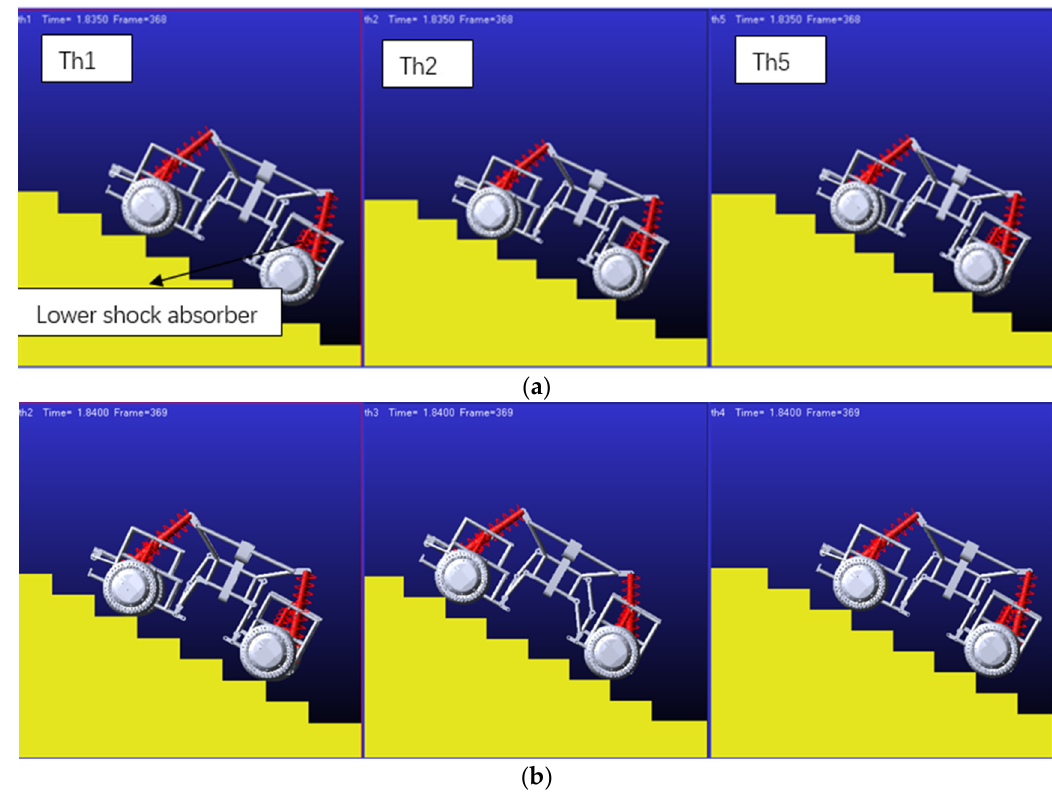
Figure 19. Vehicles with different stiffness shock absorbers climbing stairs. ( a ) Th1-Moderate stiffness, lower shock absorber, Th2-Soft stiffness, lower shock absorber, Th5-Stiffer stiffness, lower shock absorber; ( b ) Th2-Moderate stiffness, Upper shock absorber, Th3-Soft stiffness, Upper shock absorber, Th4-Stiffer stiffness, Upper shock absorber.